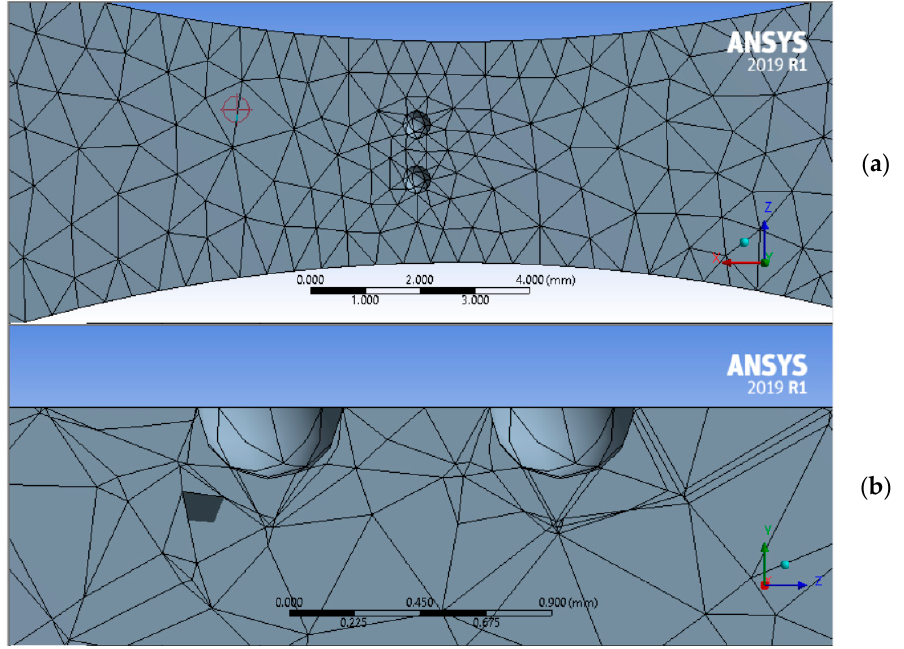
Figure 15. ( a ) Numeric 3D model for evaluate the stress intensity factor in mode I, ( b ) section view